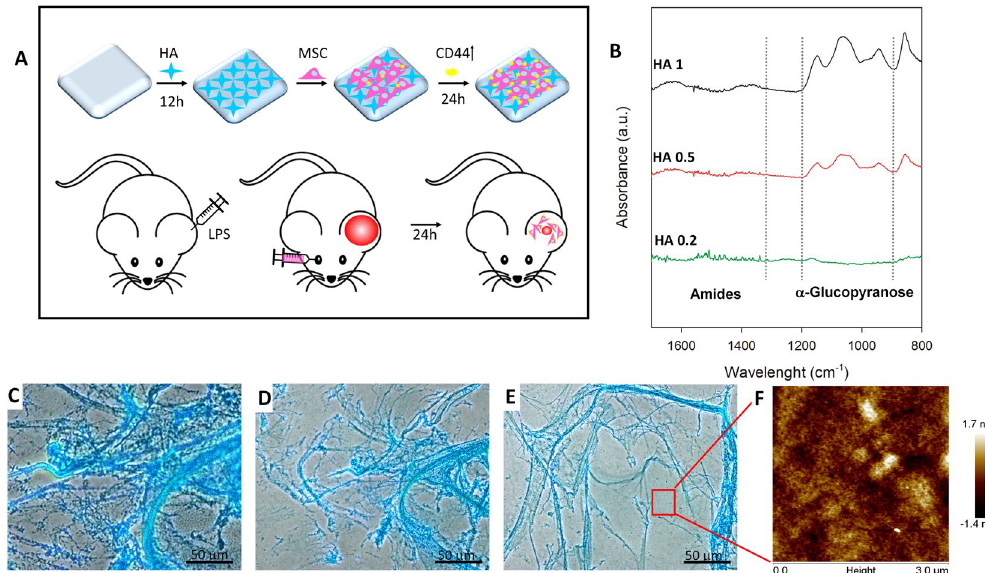
Figure 1. Schematic summarizing the proof of concept of the overall study ( A ). ATR-FTIR spectra of HA coated substrate at 0.2 (HA 0.2), 0.5 (HA 0.5), 1 (HA 1) mg/ml ( B ). Alcian Blue staining of the coating reveals the formation of a stable fibrotic coating on the surface of TCP ( C ) after 2 ( D ) and 4 washes ( E ). Atomic Force Microscope images of the surface show a thick and uniform layer of HA at the nanoscopic level ( F ). AFM- tip scratching showed the thickness of the HA multi-layers absorbed onto the TCP